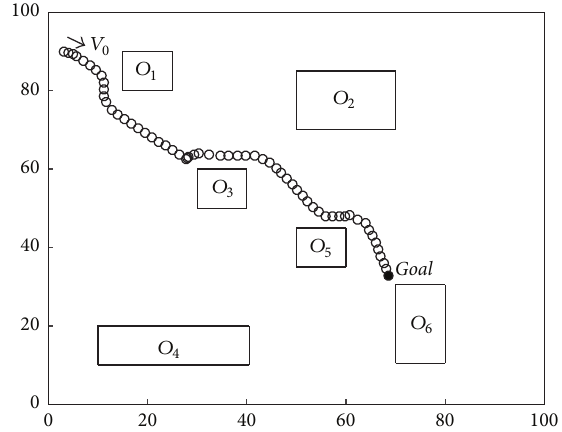
Figure 12: The simulation of the OMR controlled by dynamics controller moving in the workplace.